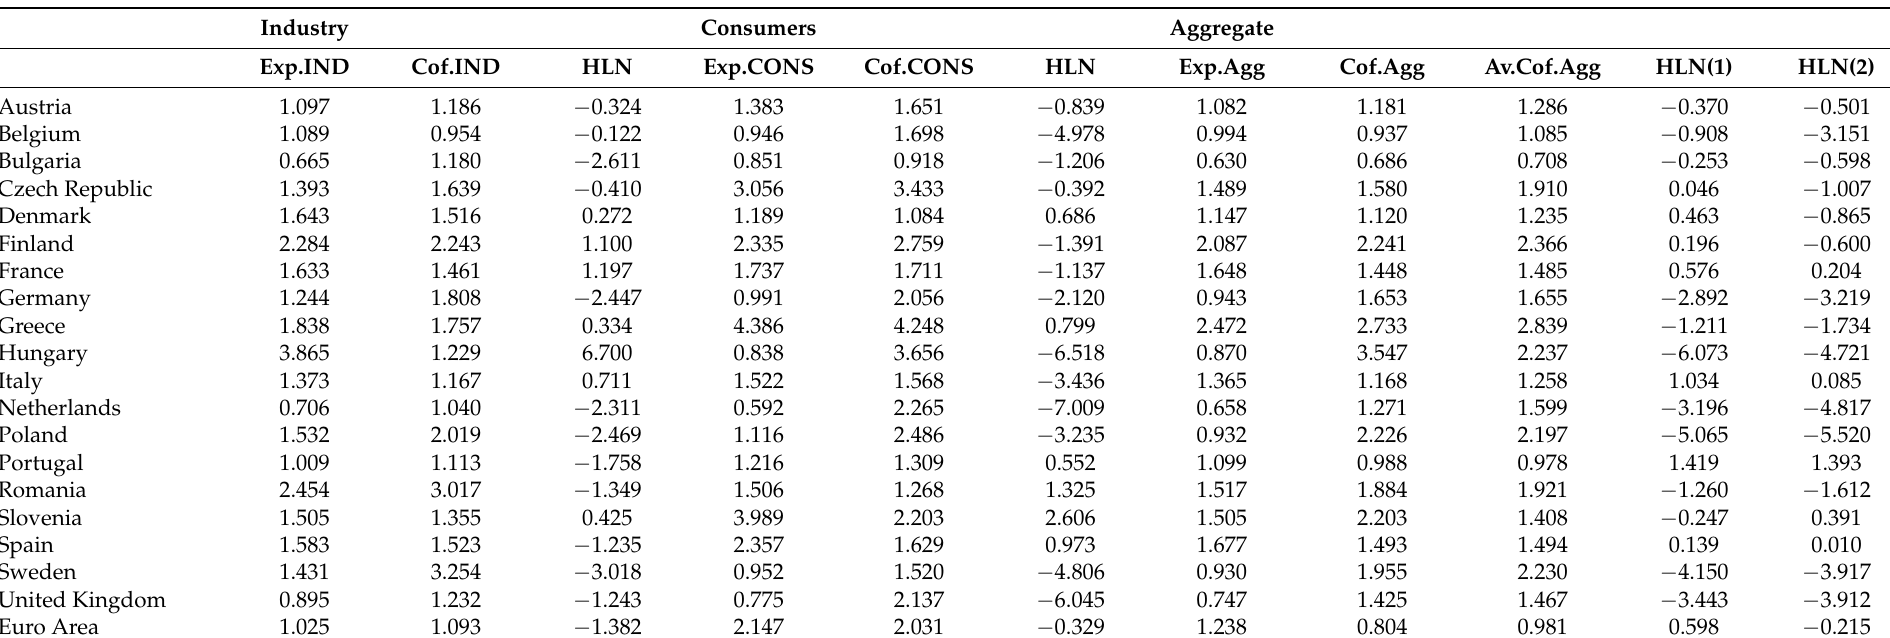
Table 3. Forecast accuracy (RMSFE): Evolved indicators (Exp.) vs. Scaled indicators (Cof.)—Industry and consumer surveys and Aggregate